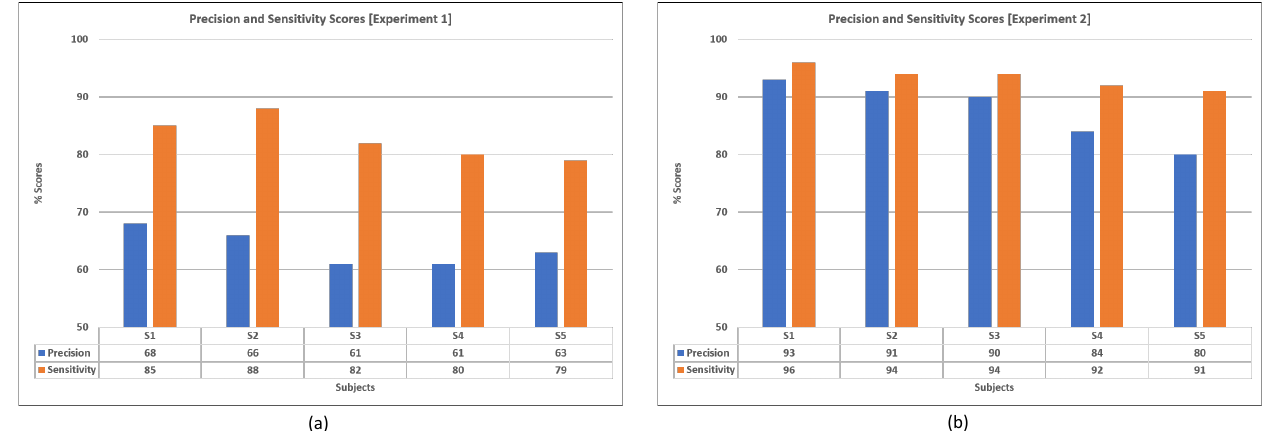
Figure 8. Precision and sensitivity values of ( a ) Experiment 1, ( b ) Experiment